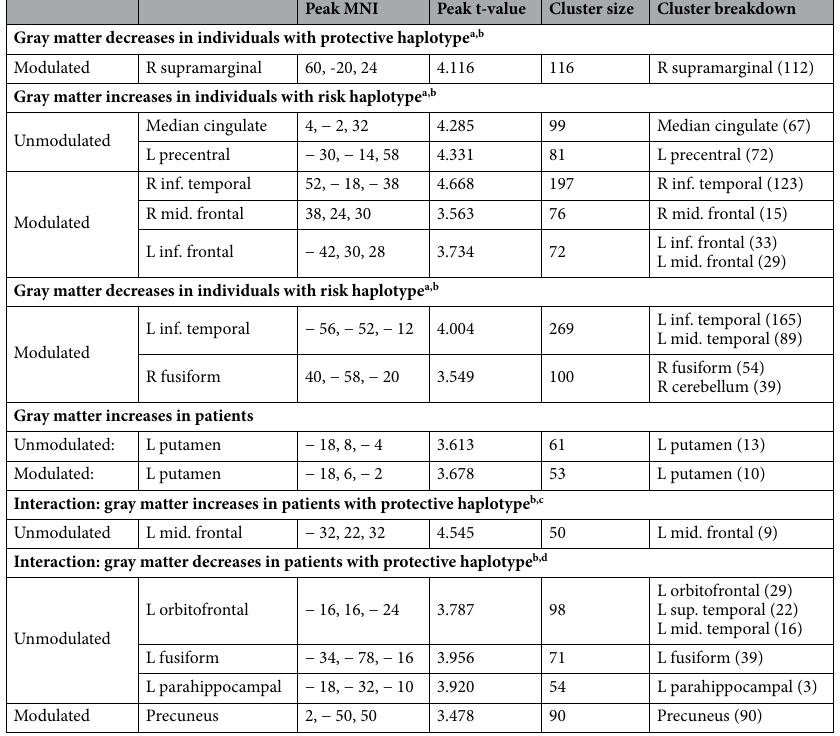
Table 2. Effects of ADHD and ADGRL3 haplotypes on gray matter volume (Contrasts Patients < controls, Protective > other haplotypes, and Patients with Risk > or < Controls with other haplotypes, did not returned significant results). Inf. Inferior, L left, mid. Middle, R right, sup. superior. a In the absence of disorder- haplotype interactions. b We compared risk and protective haplotype to other haplotypes. c Trend-level increase in individuals with protective haplotype, trend-level increase in patients, and extra increase in patients with protective haplotype. d No overall effects of protective haplotype or disorder, but decrease in patients with protective